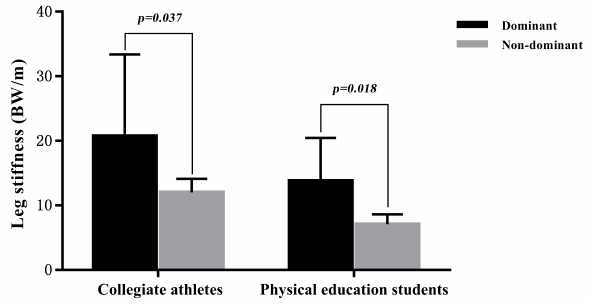
Fig. 1. Comparison of lower limb stiffness of dominant and non-dominant leg at H-SLDJ.